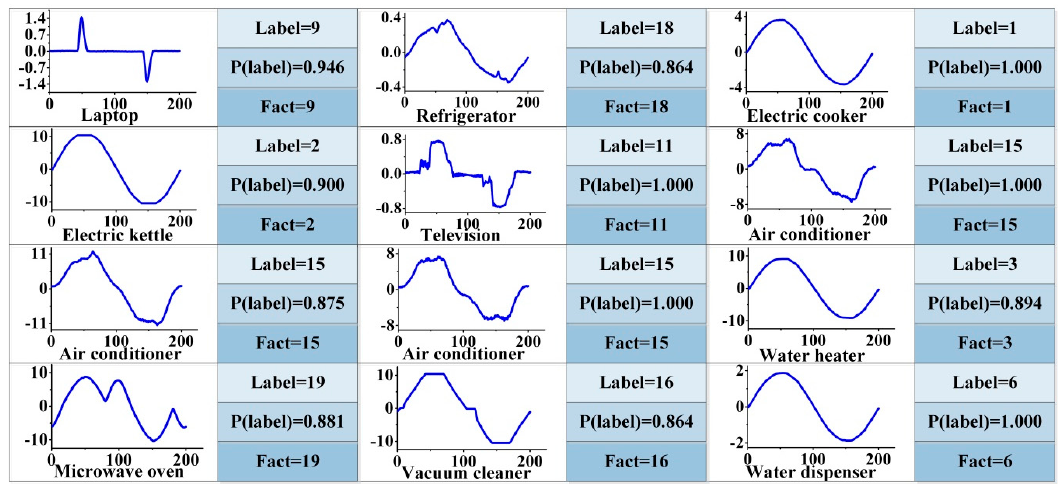
Figure 8. Labeling results of individual appliances.